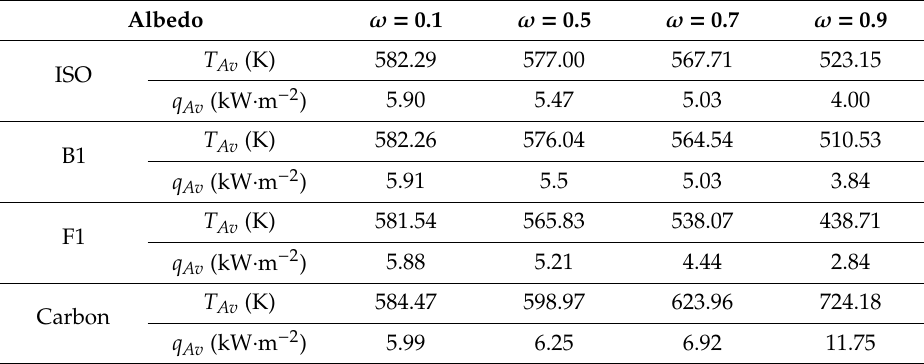
Table 3. Average temperature and net radiation heat flux density value for different albedo values ( κ = 5 m −1 ).